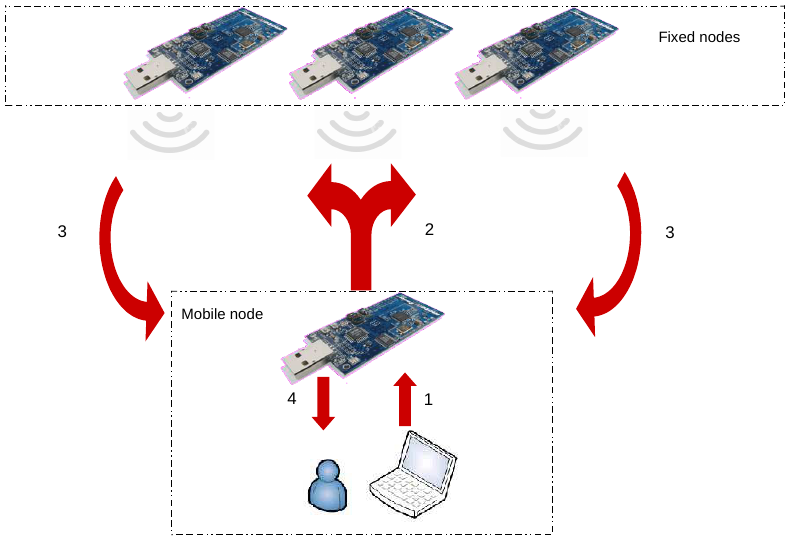
Figure 11. Initialization of tracking procedures. A start activation message (1) is broadcast to the network (2). The received data message (3) is (as far as the localization application is concerned) uniquely used to estimate the RSSI value (4), that is then processed to obtain the position estimation.